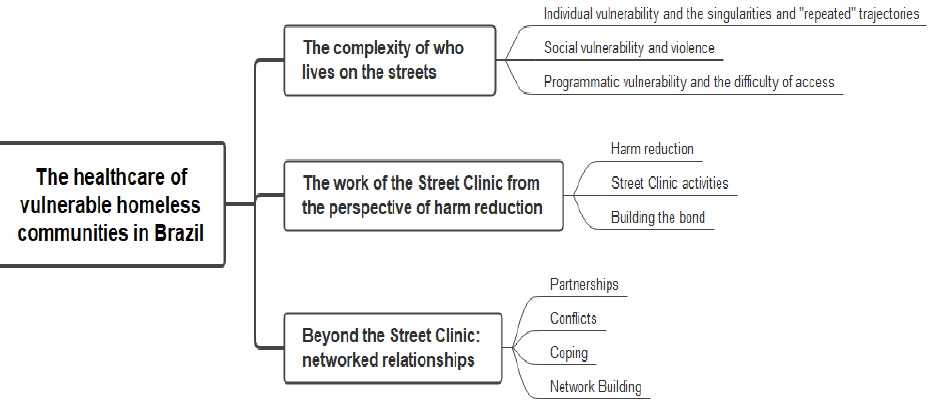
Figure 1. Concept map to view the analysis of results. Brazil, 2021.